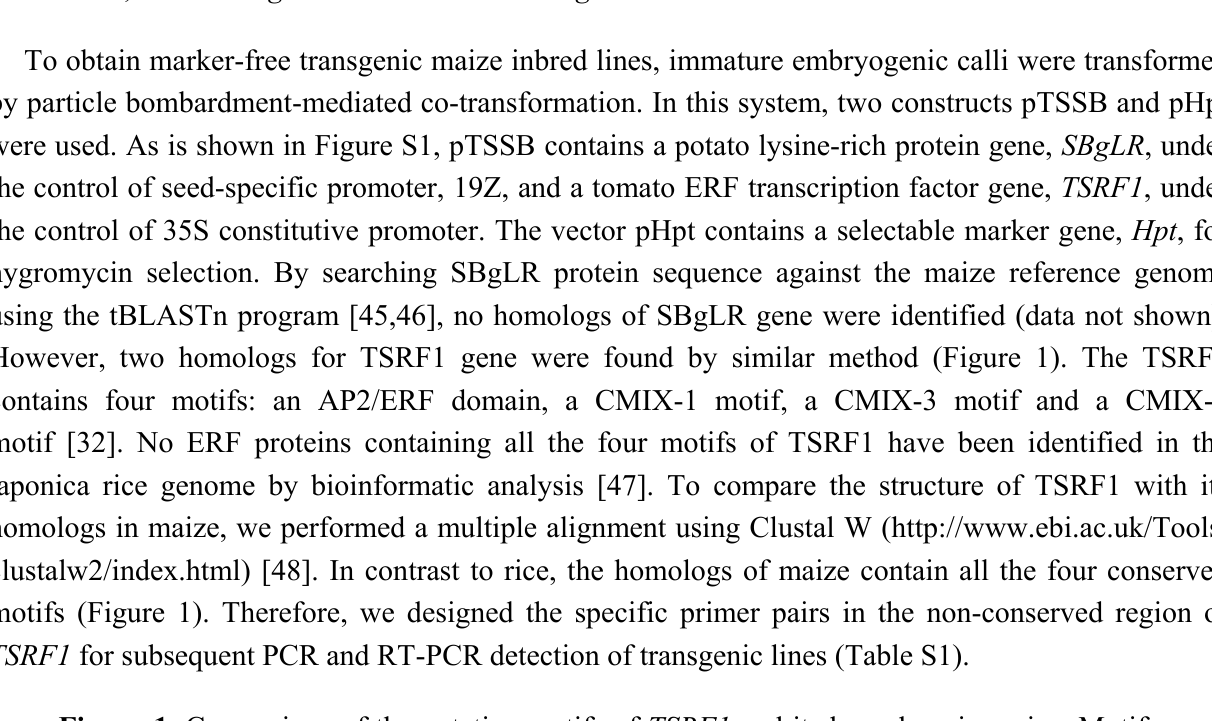
Figure 1. Comparison of the putative motifs of TSRF1 and its homologs in maize. Motifs of TSRF1 were marked by black lines on the top of the